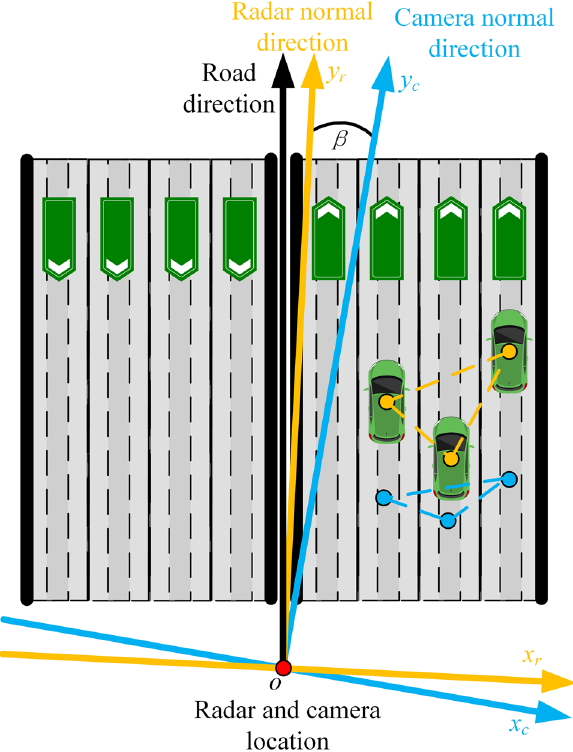
Figure 5. Sensors deployment schematic for radar-camera